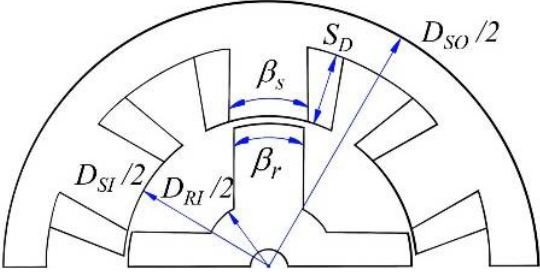
Figure 10. Geometry of the SRM’s initial design.